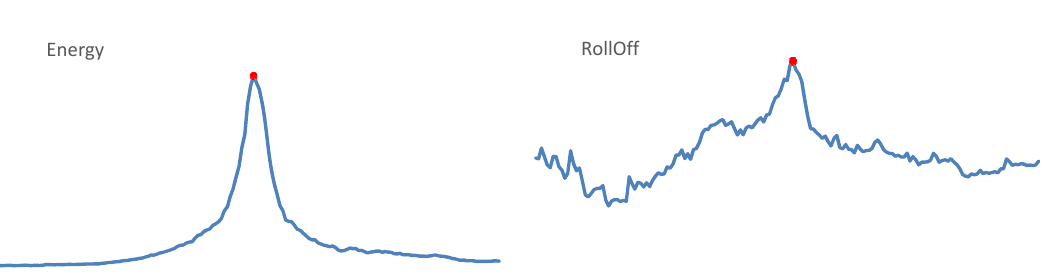
Figure 6. Evolution of exemplary features (Energy and RollOff) in time through the entire 10 s segment. The central point is marked in